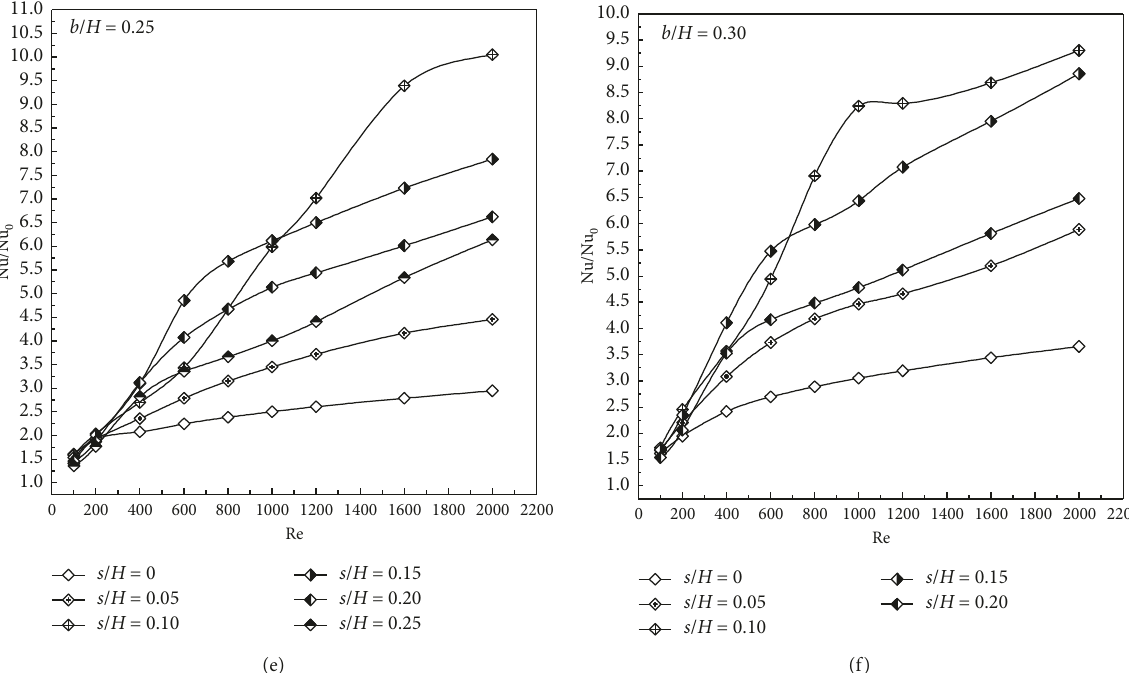
Figure 16: Nu/Nu 0 versus Reynolds number for the heat exchanger square duct installed with the 45 b / H 0.15, (d) b / H 0.20, (e) b / H (cid:31) (cid:31)